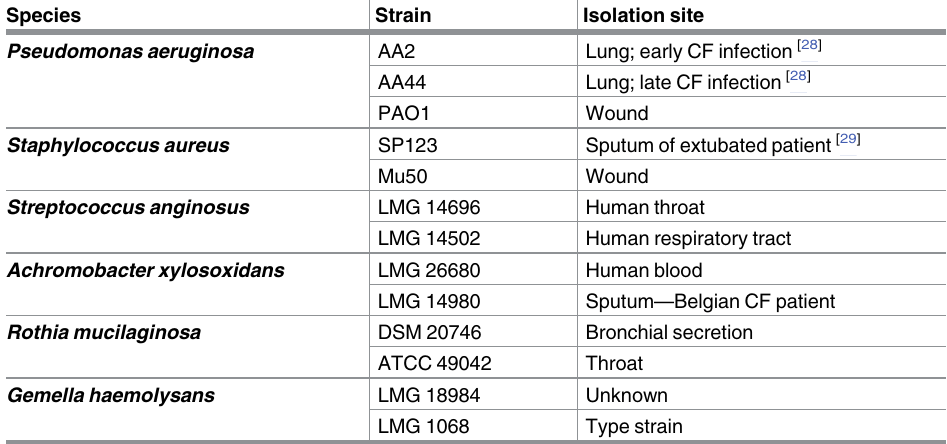
Table 1. Overview of strains used in this study and isolation